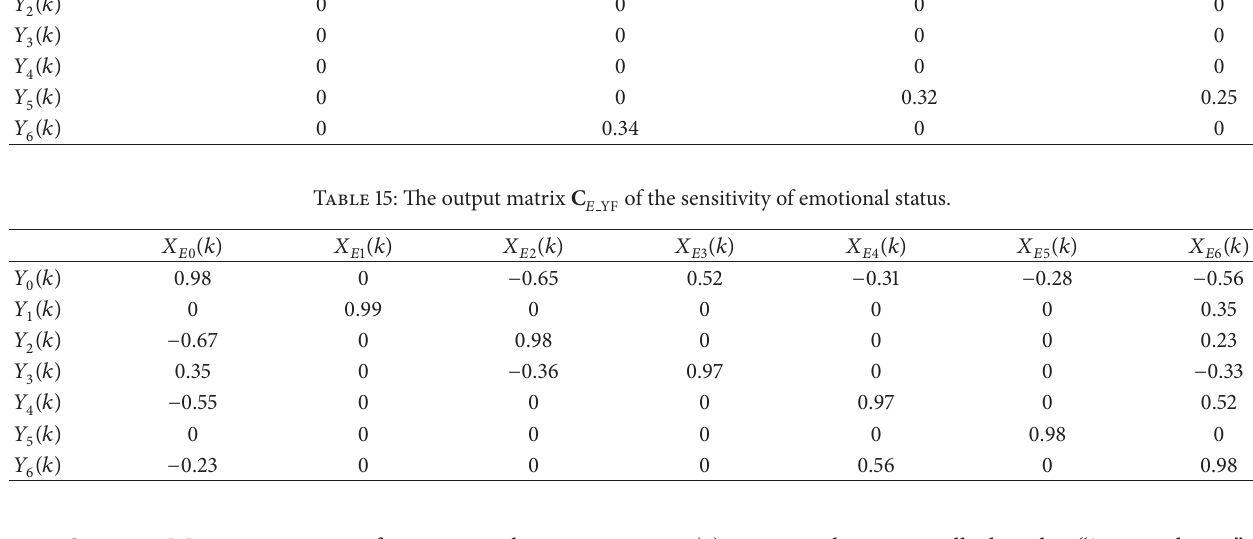
of the sensitivity of reactive stimuli. YF